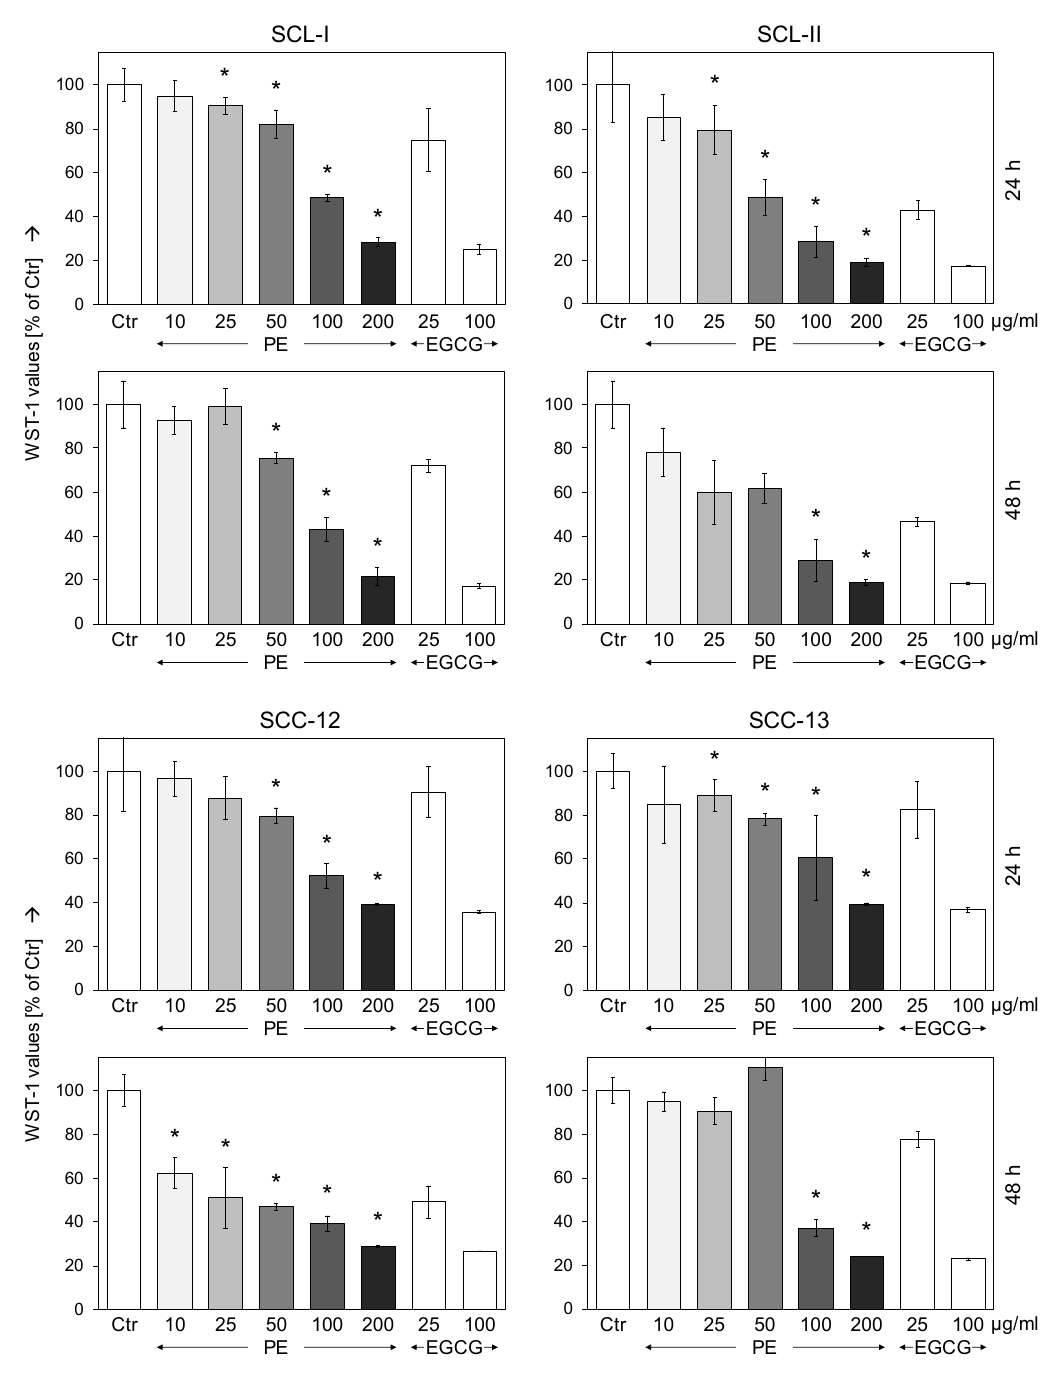
Figure 1. Reduced cell proliferation by P E . SCL ‐ I, SCL ‐ II, SCC ‐ 12, and SCC ‐ 13 were seeded in 96 ‐ well pates and were treated with increasing concentrations of PE (10 ‐ 200 μ g/mL). As controls, EGCG was used at 25 and 100 μ g/mL. Cell proliferation was quantified by WST ‐ 1 assay at 24 h and at 48 h of treatment. One of two independent experiments is shown here, each one consisting of triplicate values. Effects on cell proliferation are shown as percentages of non ‐ treated controls (Ctr = 100%). Statistical significance of PE treatments was calculated from all individual values (#6) and is indicated by asterisks ( p < 0.05, as compared to Ctr).